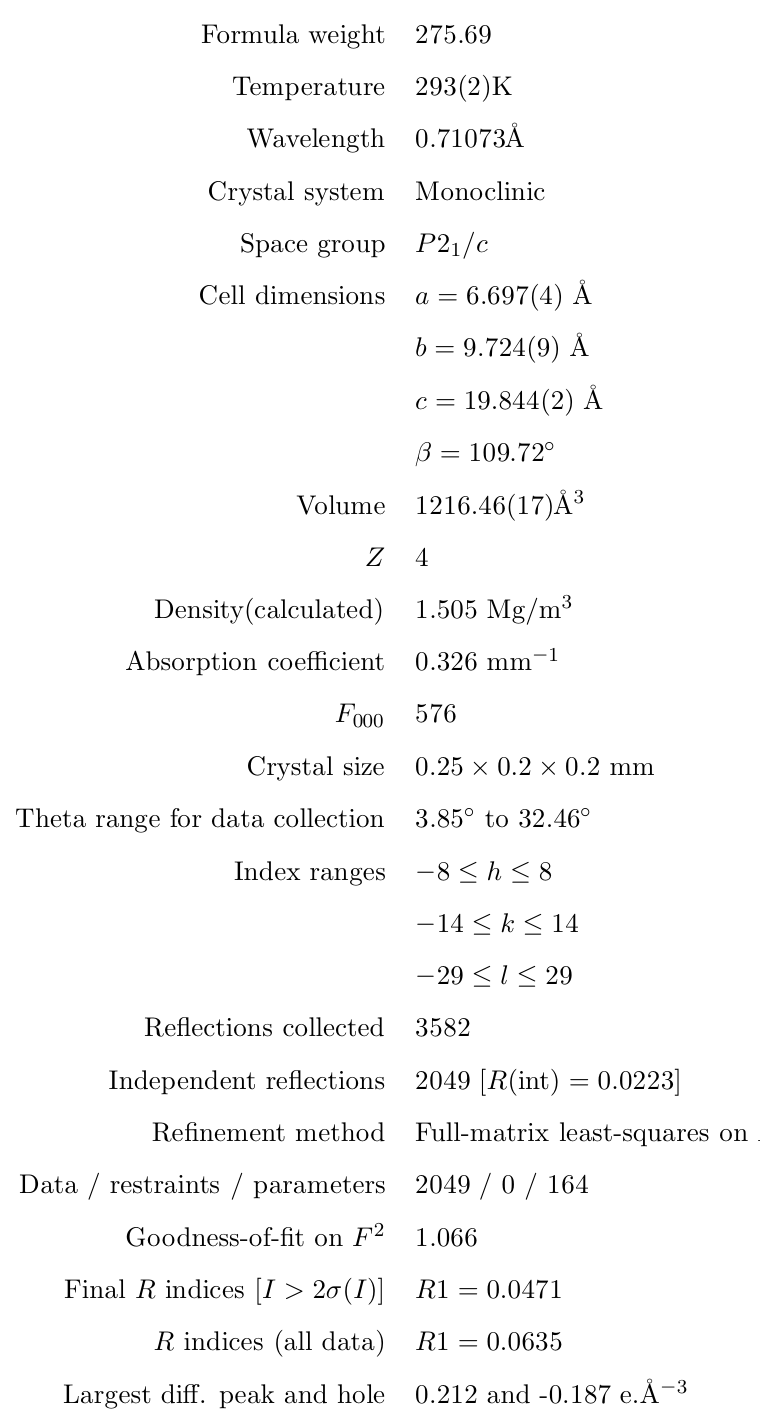
Table 1 Experimental crystallographic details of 6 +